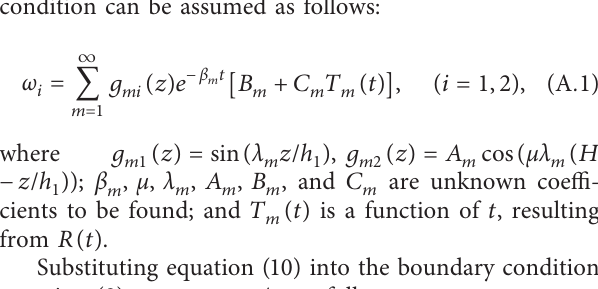
s and U p with time factor